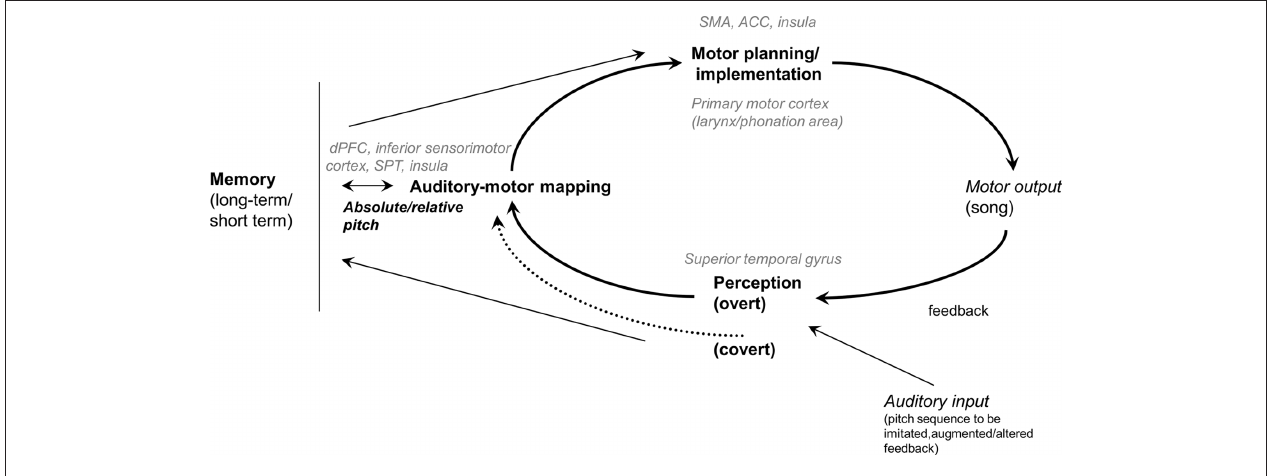
FiguRe 1 | Schema of the vocal sensorimotor loop (VSL; see also Berkowska and Dalla Bella, 2009b). The brain regions likely associated with the functional components of the VSL are indicated in gray. SMA,